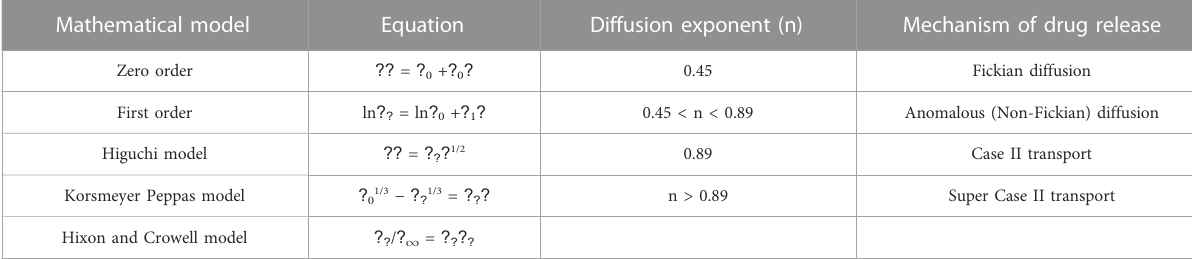
TABLE 3 Models to ascertain the kinetic of drug